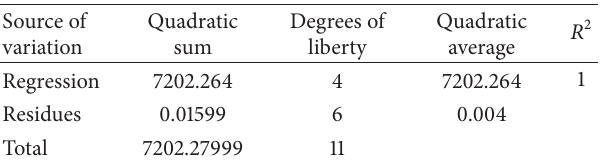
Table 5: Adjustment of variance analysis of the points presented in Figure 10. Source of Quadratic Degrees of Quadratic 𝑅 2 variation sum liberty average Regression 7202.264 4 7202.264 1 Residues 0.01599 6 0.004 Total 7202.27999